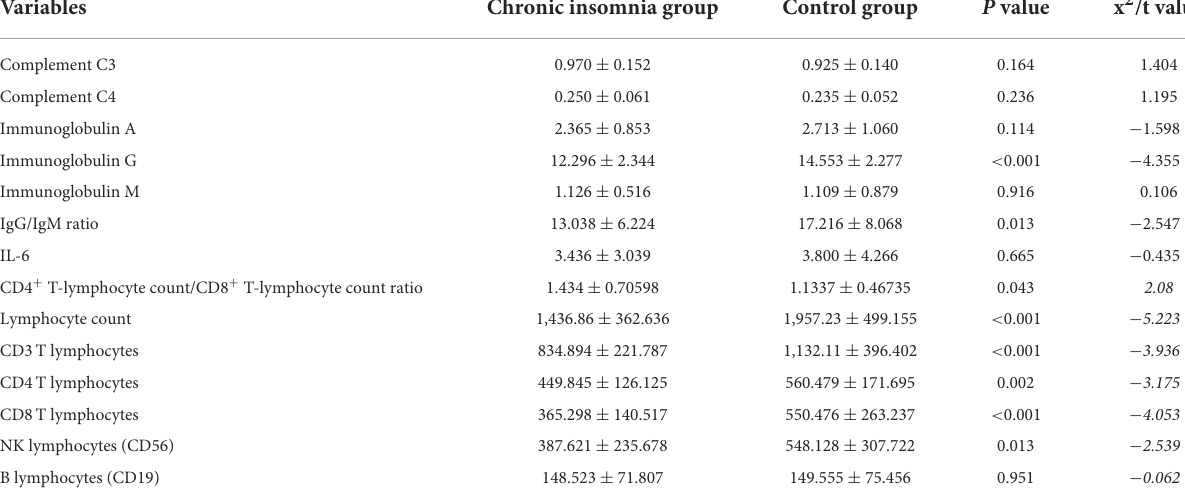
TABLE 3 Comparison of immunological indices between the two groups.